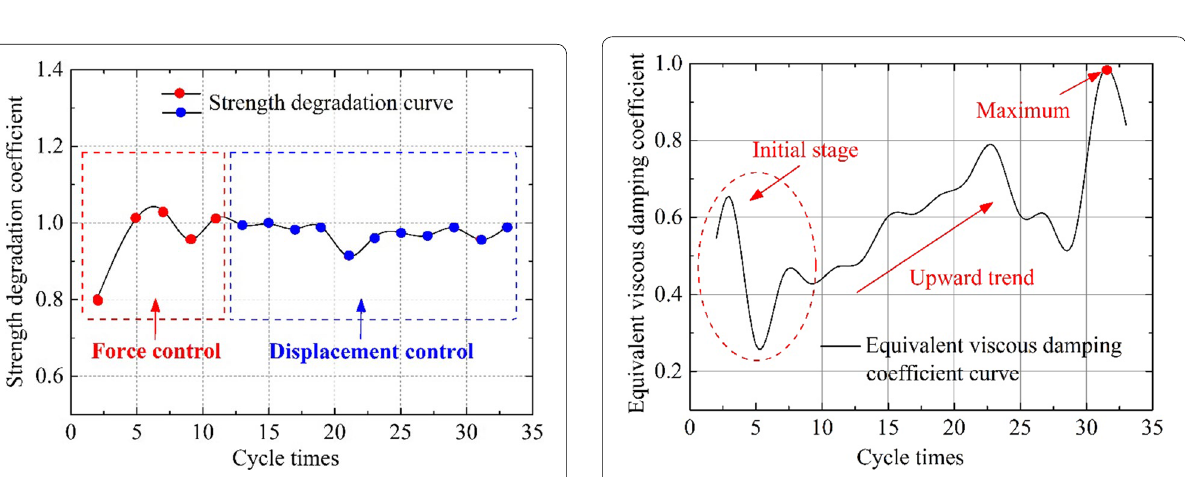
Fig. 10 Strength degradation curve